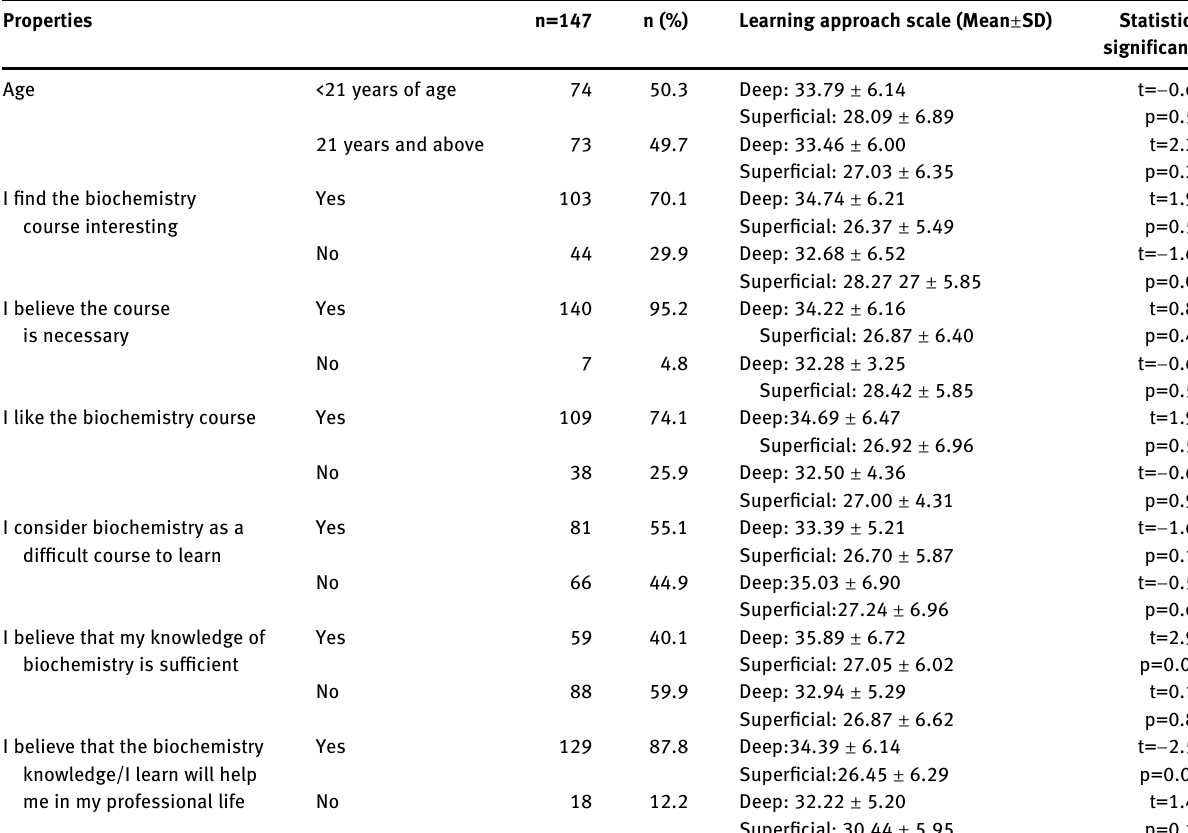
Table  : Comparison of some determinants of students ’ learning approaches(LA). Properties